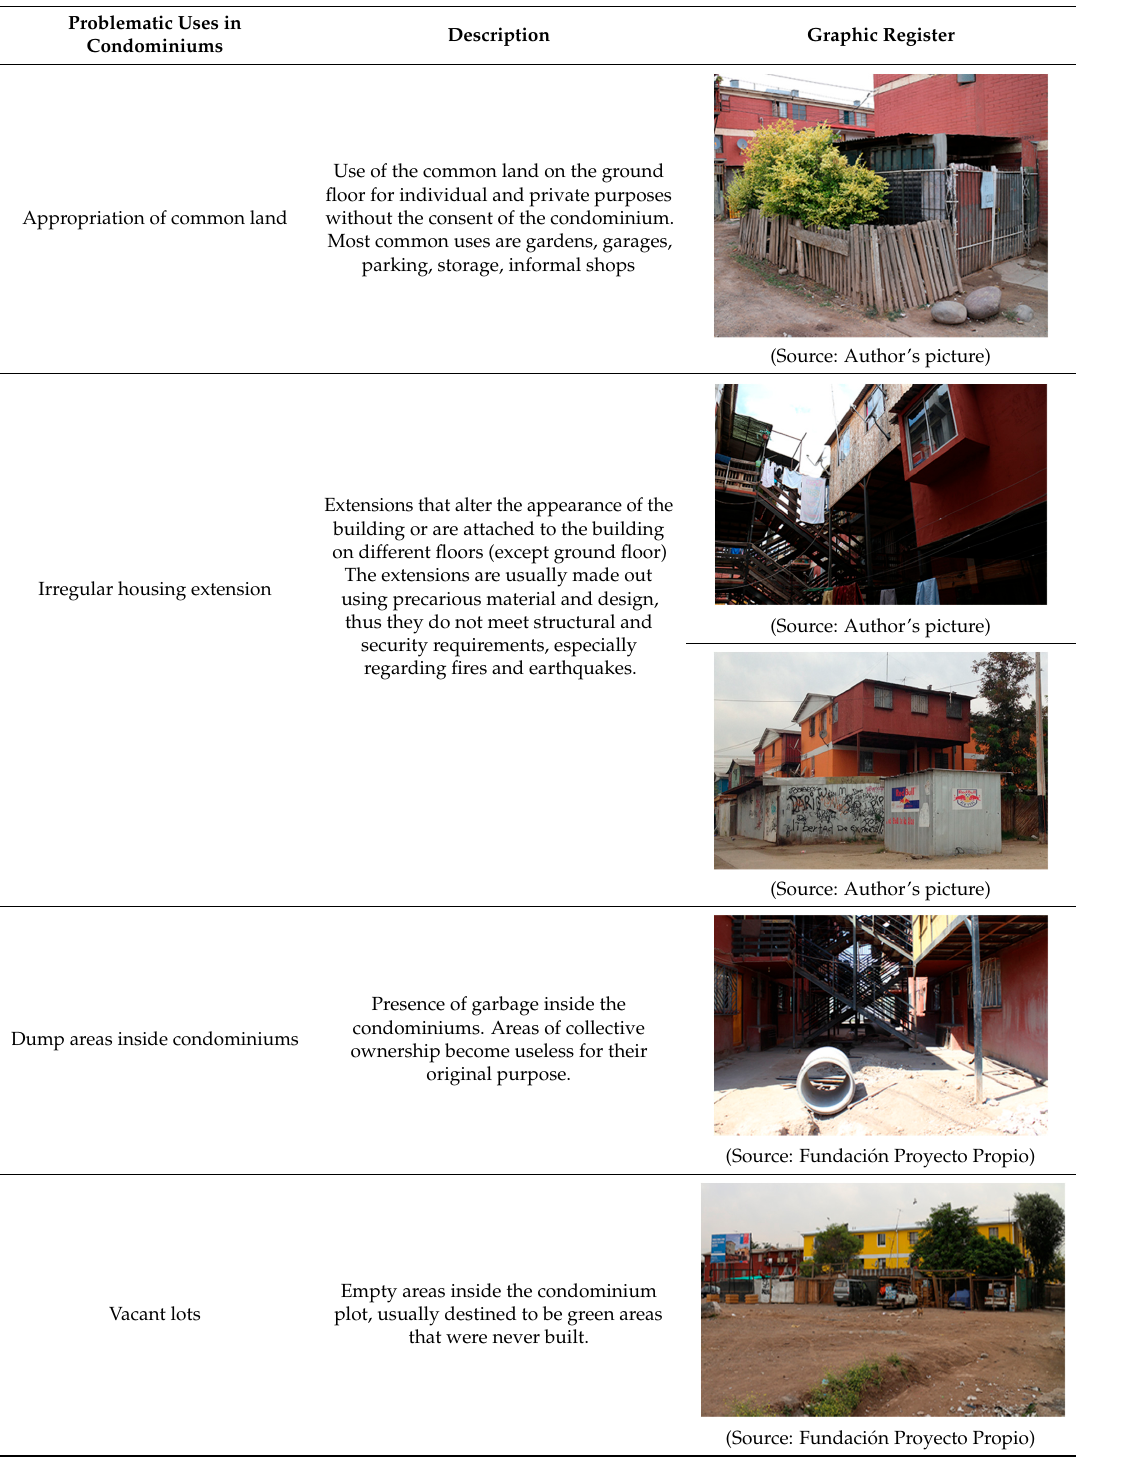
Table 1. Maintenance problems and problematic uses in social condominiums.